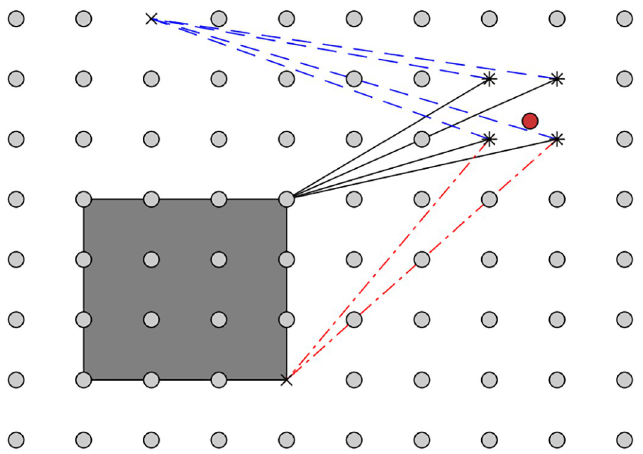
Fig 3. Example of the search process in Alg. 1. The red circle is the fuzzy point p , from which the distance is computed, and the four nearby star ( � ) markers indicate the nearest grid points ( P ). The two crosses ( × ) represent points of S that surpass the sampled intensity threshold α . The gray rectangle shows the region ( y , R ) corresponding to the current node i in the KD-tree. The (lengths of the) dashed lines (blue) represent the distances from each of the nearest grid-points to the current closest point (the upper × ). The (lengths of the) solid lines (black) represent the lower bound of the distance to any point within the rectangle. In the example, the lower bound is smaller than at least one of the current lowest distances, and the rectangle contains at least one object point, and thus the sub-tree will be searched. The (lengths of the) dash-dotted (red) lines represent the distances from the grid-points for which a closer point was found by searching within the